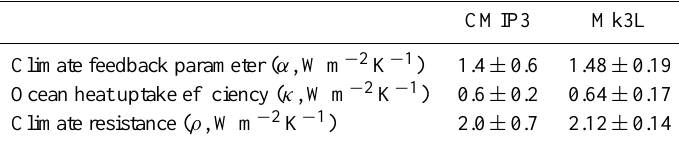
Table 2. The climate feedback parameter ( α ), ocean heat uptake efficiency ( κ ) and climate resistance ( ρ ) for the CMIP3 AOGCMs (Gregory and Forster, 2008) and Mk3L. The 5–95% uncertainty range is shown for the CMIP3 ensemble, and the 95% confidence interval is shown for